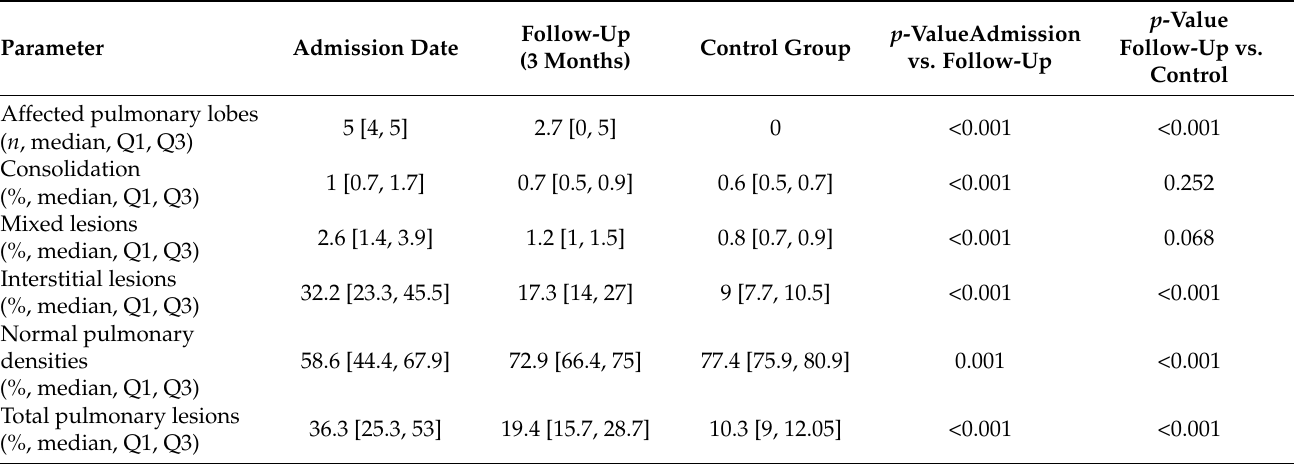
Table 2. Radiologic parameters in the study